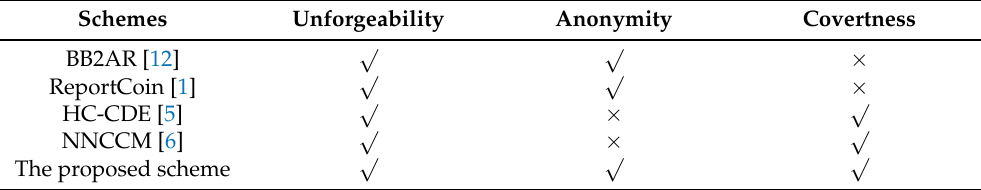
Table 2. Comparison with existing anonymous reporting schemes and covert communication